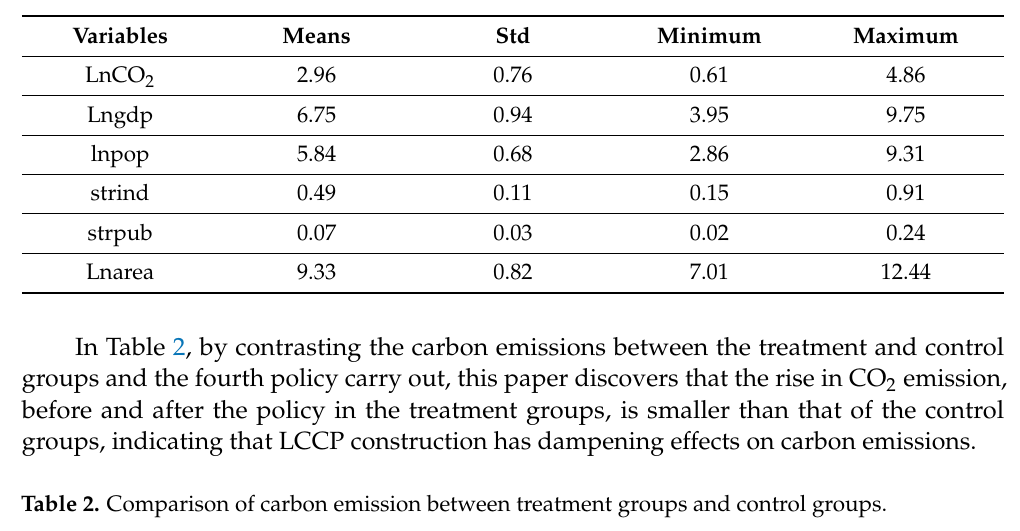
Table 1. Descriptive analysis (Obs: 3058).